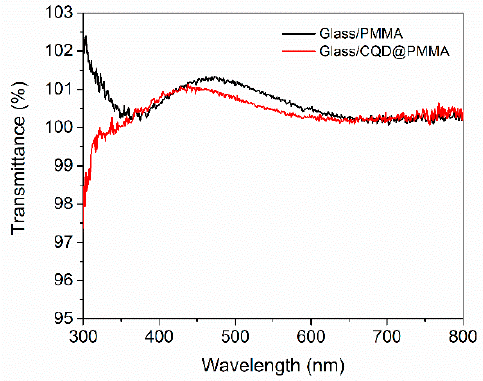
Figure 3. Transmittance of neat PMMA and CQD@PMMA coatings on thin microscope glass slides.